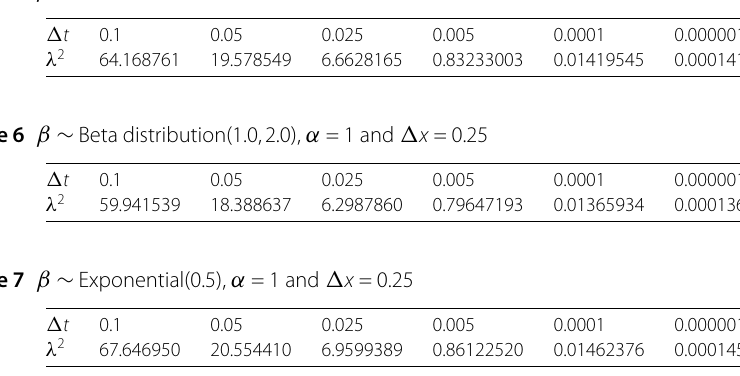
Table 5 β ∼ Binomial distribution(1.0,0.5), α = 1 and (cid:4) x = 0.25